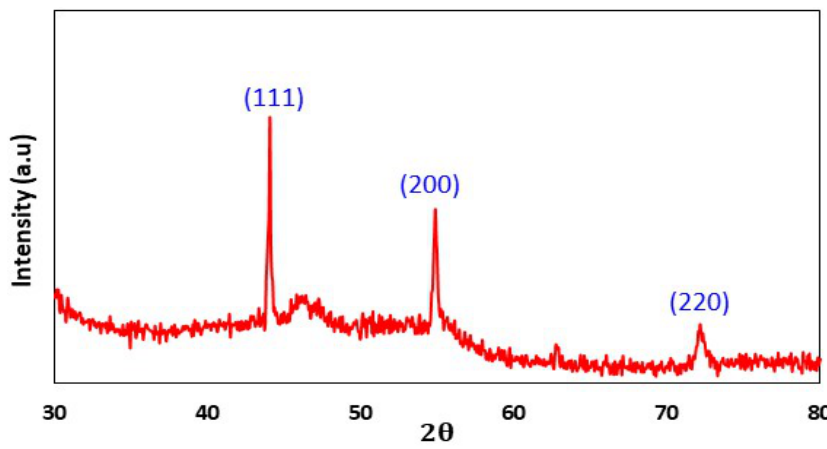
Figure 3. XRD patterns of the synthesized TVE-CuNPs.